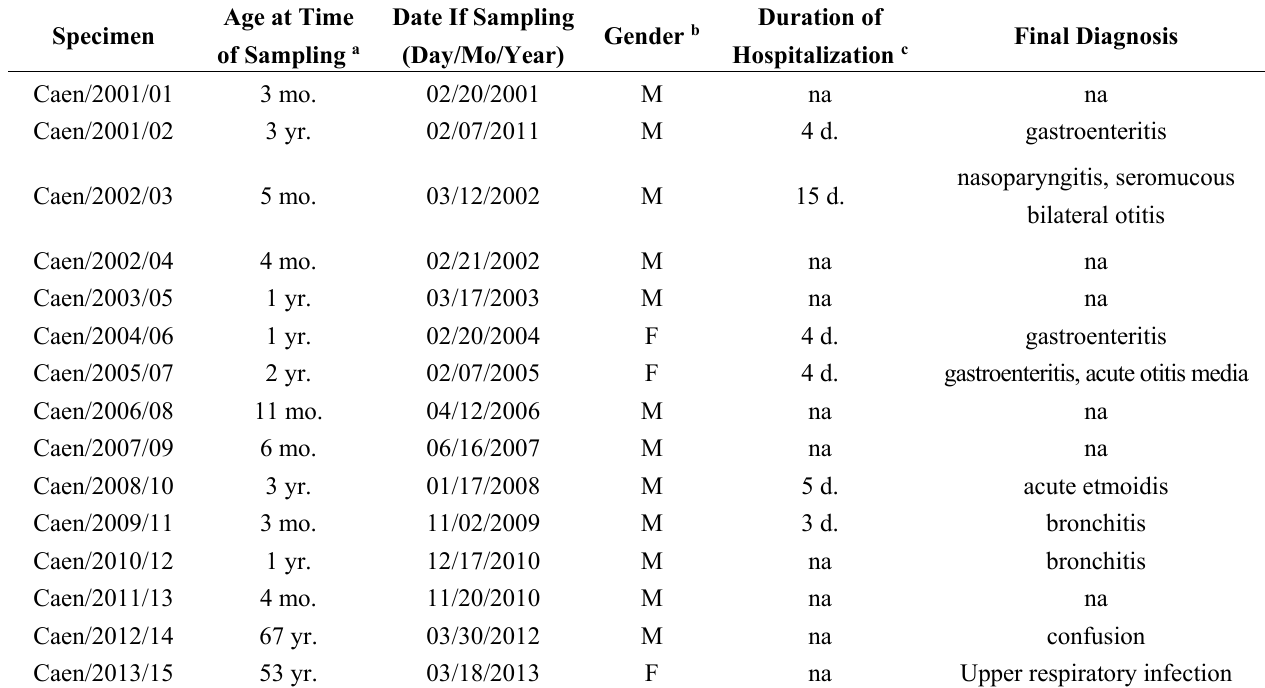
Table 3. Clinical features of the 15 french patients. a Mo., month; yr., year; d., days. b M, male; F, female. c Na, not